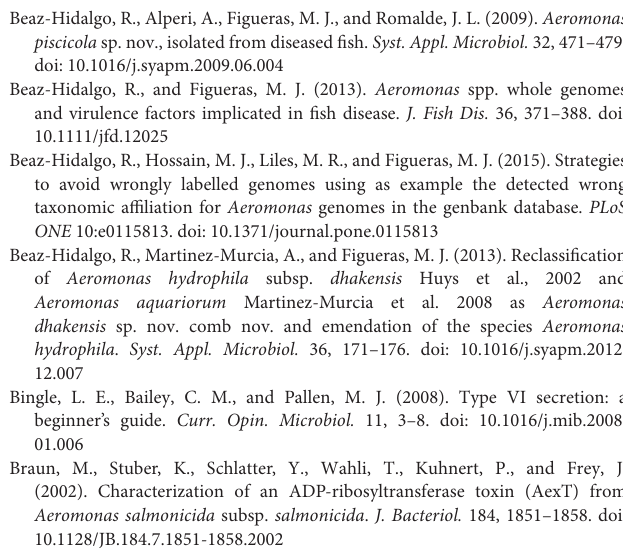
TABLE S1 | Gene products implicated in A. hydrophila virulence and the relative coverage and identity of strains listed in GenBank against the strain from which the gene product was